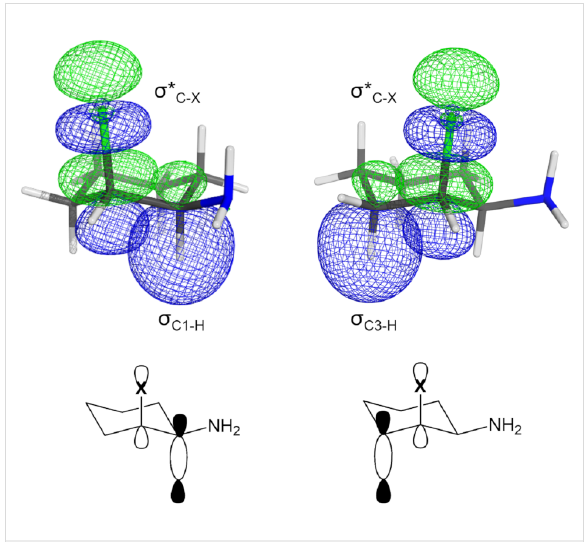
Figure 8: Orbitals overlap of σ C1–H → σ * C2–X (left) and σ C3–Hax → σ * C2–X (right) hyperconjugations in ea conformer.